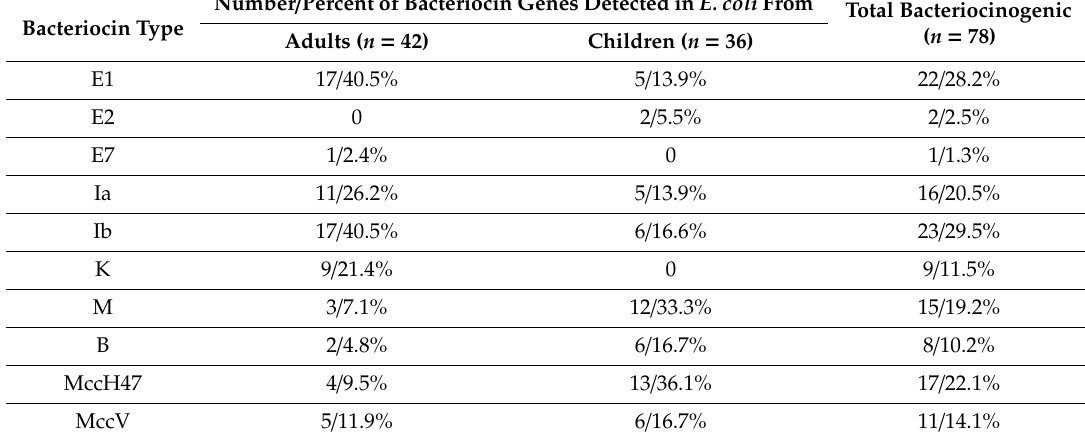
Table 1. Prevalence of bacteriocin genes in the collection of bacteriocinogenic commensal E. coli isolates from healthy adults and